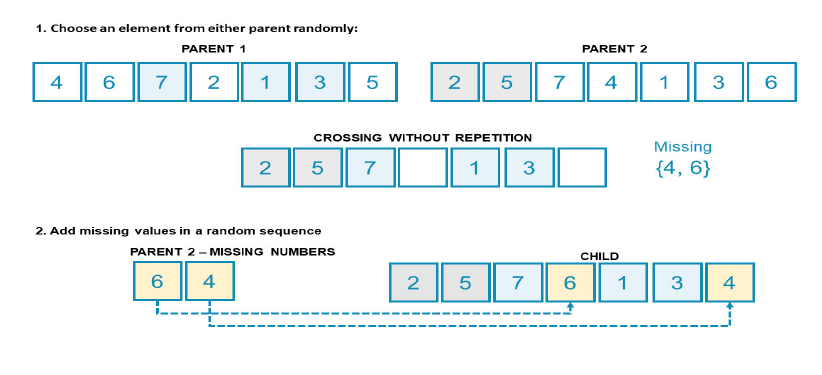
Fig. 4. An example of ULX